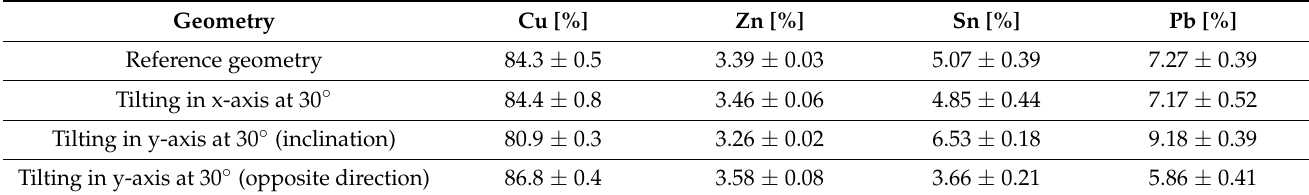
Table 2. Results of XRF analysis of a piece of copper alloy demonstrating the effect of a tilted